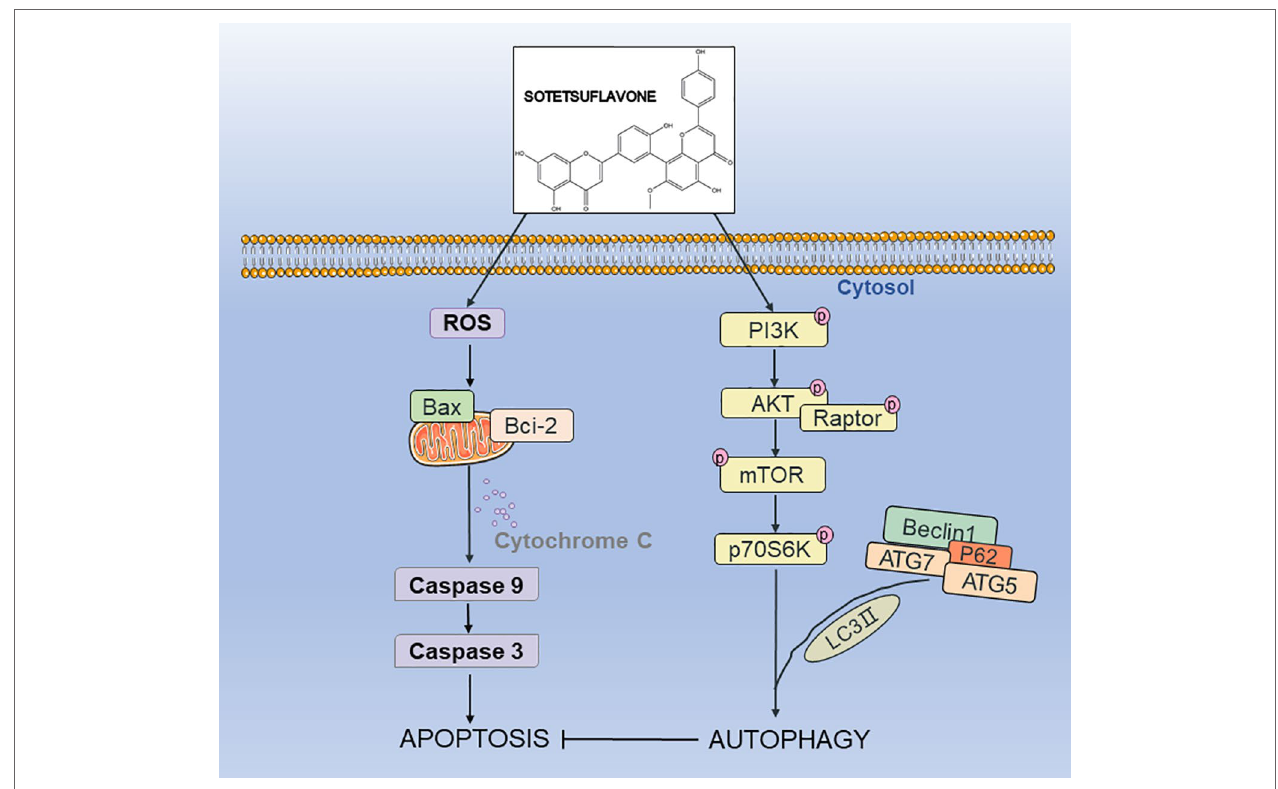
FIgURe 7 | The possible mechanism of sotetsuflavone inhibited progression of non-small cell lung cancer. Sotetsuflavone could induce autophagy, apoptosis, and G0/G1 phase arrest, leading to the death of non-small-cell lung cancer cells.